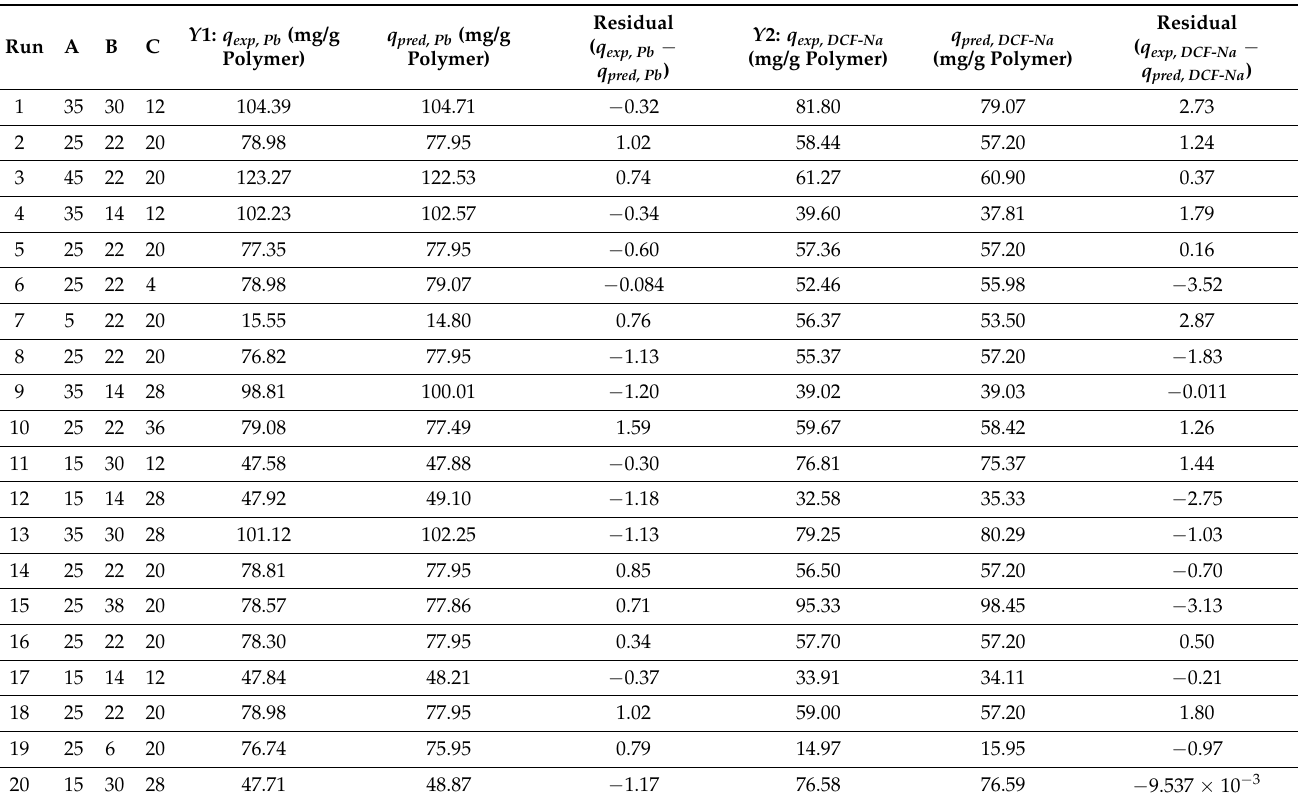
Table 2. CCD matrix with experimental ( exp ) and predicted ( pred )